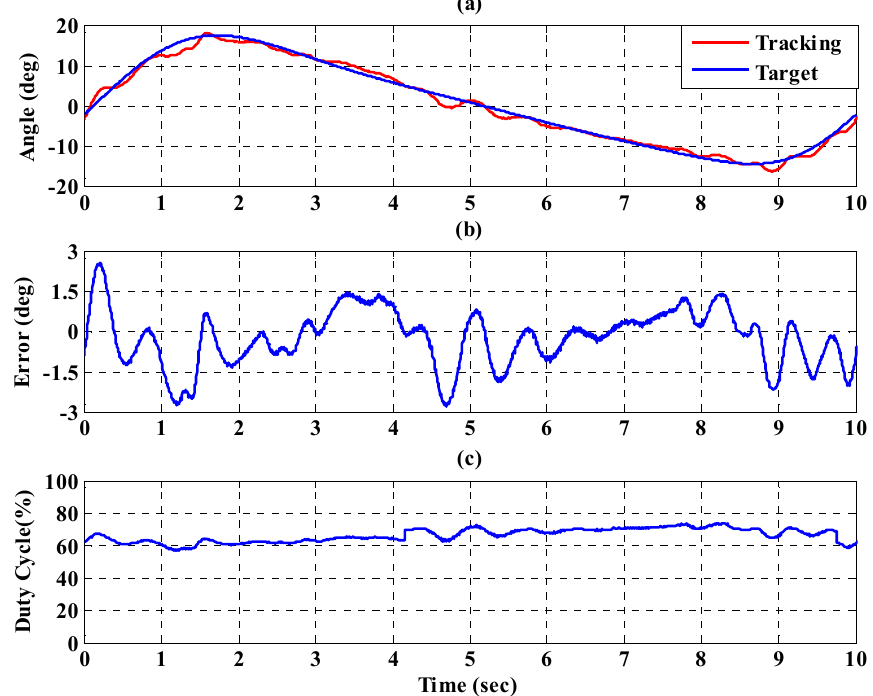
Figure 28. Tracking response of the interval type-2 fuzzy sliding pulse-width modulation controller on the left hip for the PGOS. ( a ) Output response; ( b ) tracking error; ( c ) pulse-width modulation control signal.